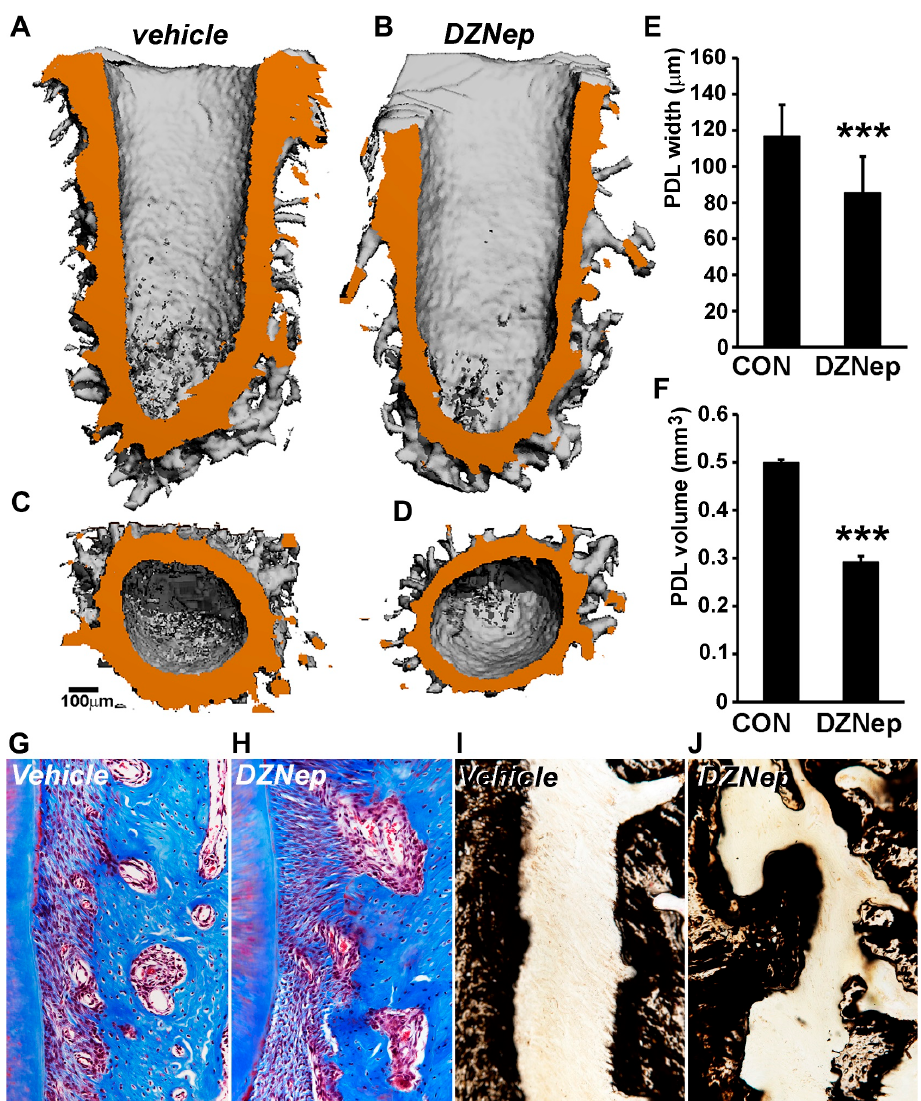
Figure 5. Aberrant mineralization and decrease in periodontal ligament width in an in vivo rat maxilla model treated with H3K27me3 inhibitor DZNep. ( A – F ) The µ CT analyses of control and inhibitor-treated rat maxilla. ( A ) Representative sagittal section derived from 3D reconstruction of distobuccal root in vehicle-treated samples. ( B ) Representative sagittal section from DZNep inhibitor- treated root samples. PDL space is rendered orange for easy visualization. Note the decreased PDL width in inhibitor-treated samples compared with vehicle-treated samples. Transverse view through distobuccal root at the mid-root region in ( C ) vehicle-treated and ( D ) DZNep-treated samples. ( E ) Quantification of average PDL width of distobuccal root in control/vehicle (con) and DZNep-treated samples. Measurements were performed on Image J software (NIH) along the entire length of the PDL space. More than 50 measurements were performed for each sample (n = 10). ( F ) Comparison of total PDL volume (tissue volume) of distobuccal root in control/vehicle (con) and DZNep inhibitor- treated samples. Additionally, 3–4 volume measurements were performed for each sample (n = 10). ( G , H ) Representative histomicrograph of Masson’s trichrome staining for vehicle (control) and DZNep-treated rat maxillary first molar. ( I , J ) Von Kossa staining for mineral deposits in vehicle (control) and DZNep-treated samples. Note the mineralized outgrowths in inhibitor-treated samples. Measurements are graphed as mean ± SD. (*** p <